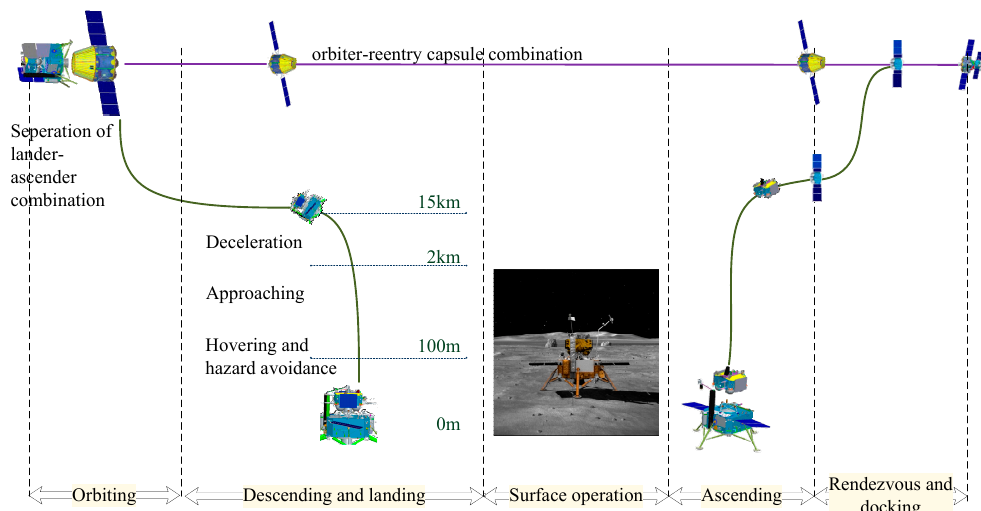
Figure 1. Diagram of descending, landing, ascending, rendezvous and docking.